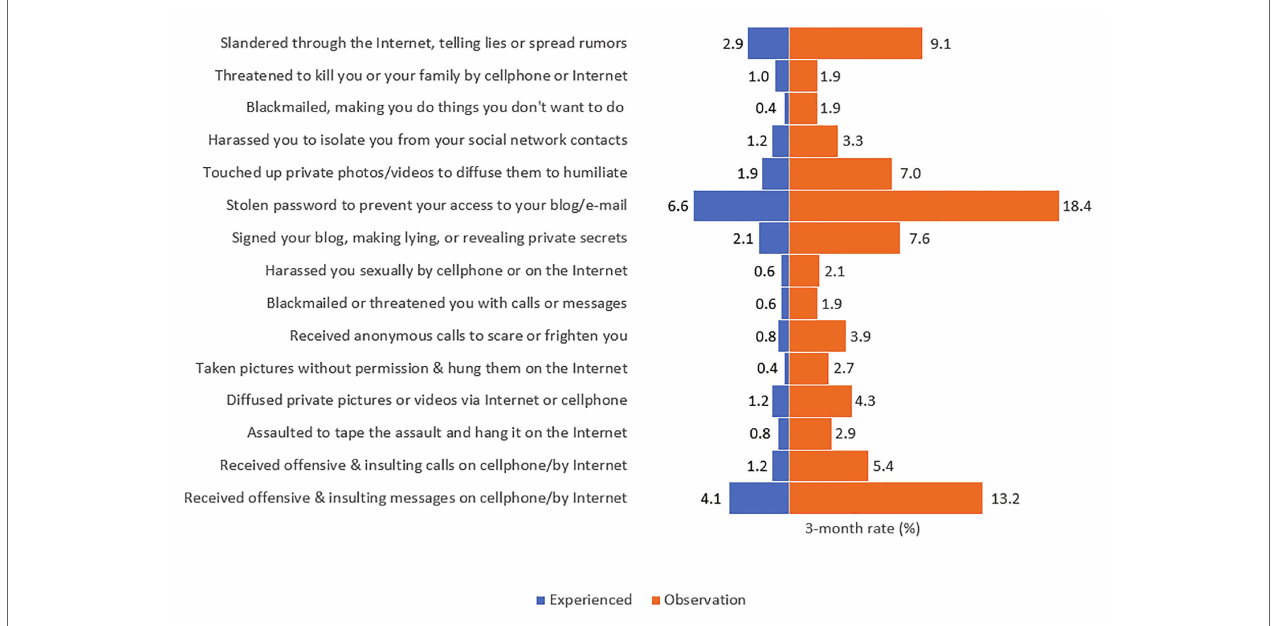
FIGURE 1 | The 3-month rates of different cyberbullying behaviors in the study population ( n =